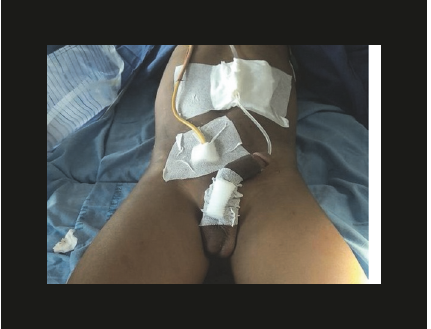
Figure 15: Postoperative dressing with urethral and suprapubic catheter (case